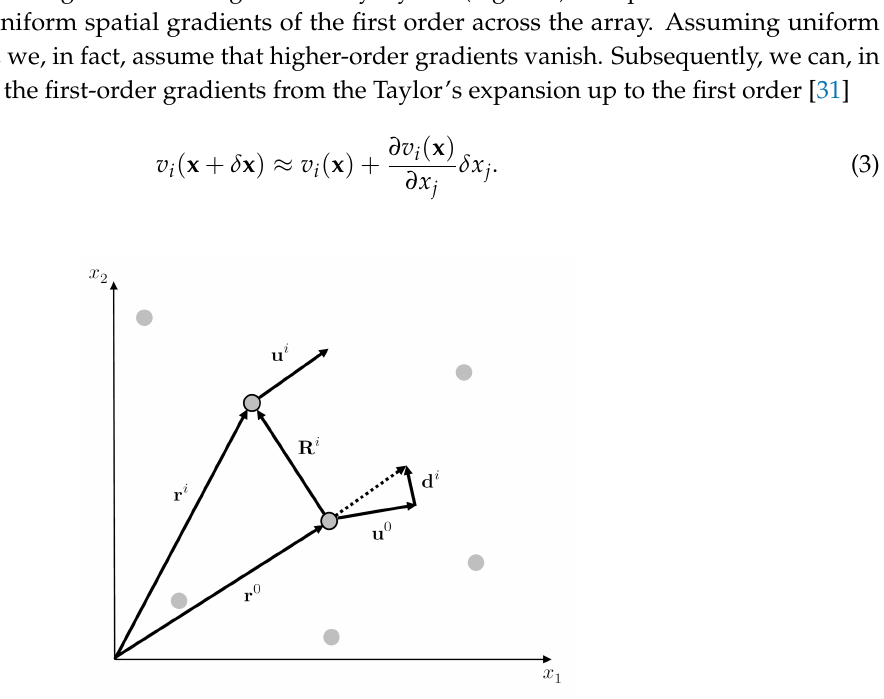
Figure 9. A scheme of an array in a general layout with definitions of the vectors used in the array-derived-rotation (ADR)